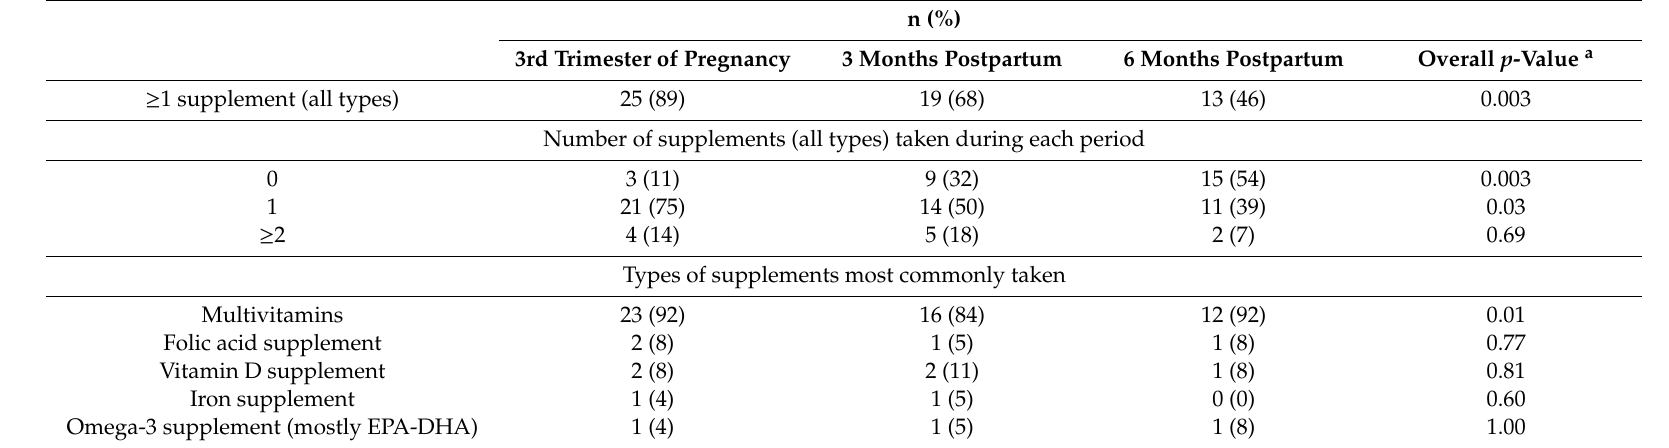
Table 4. Proportions of vitamin- and mineral-supplement users among